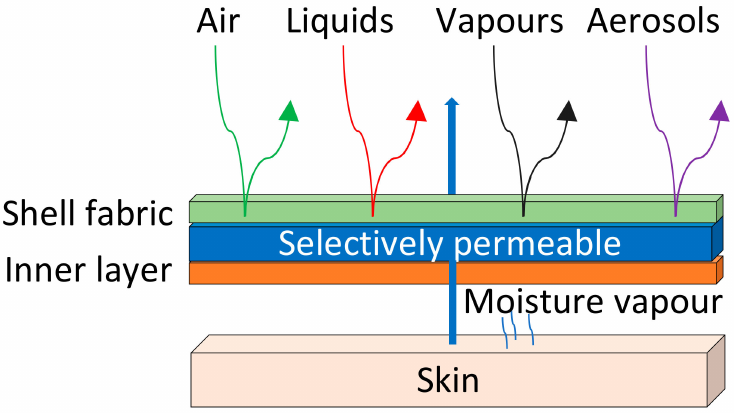
Figure 2. Detailed schematic drawing of a selectively permeable membrane (adapted from